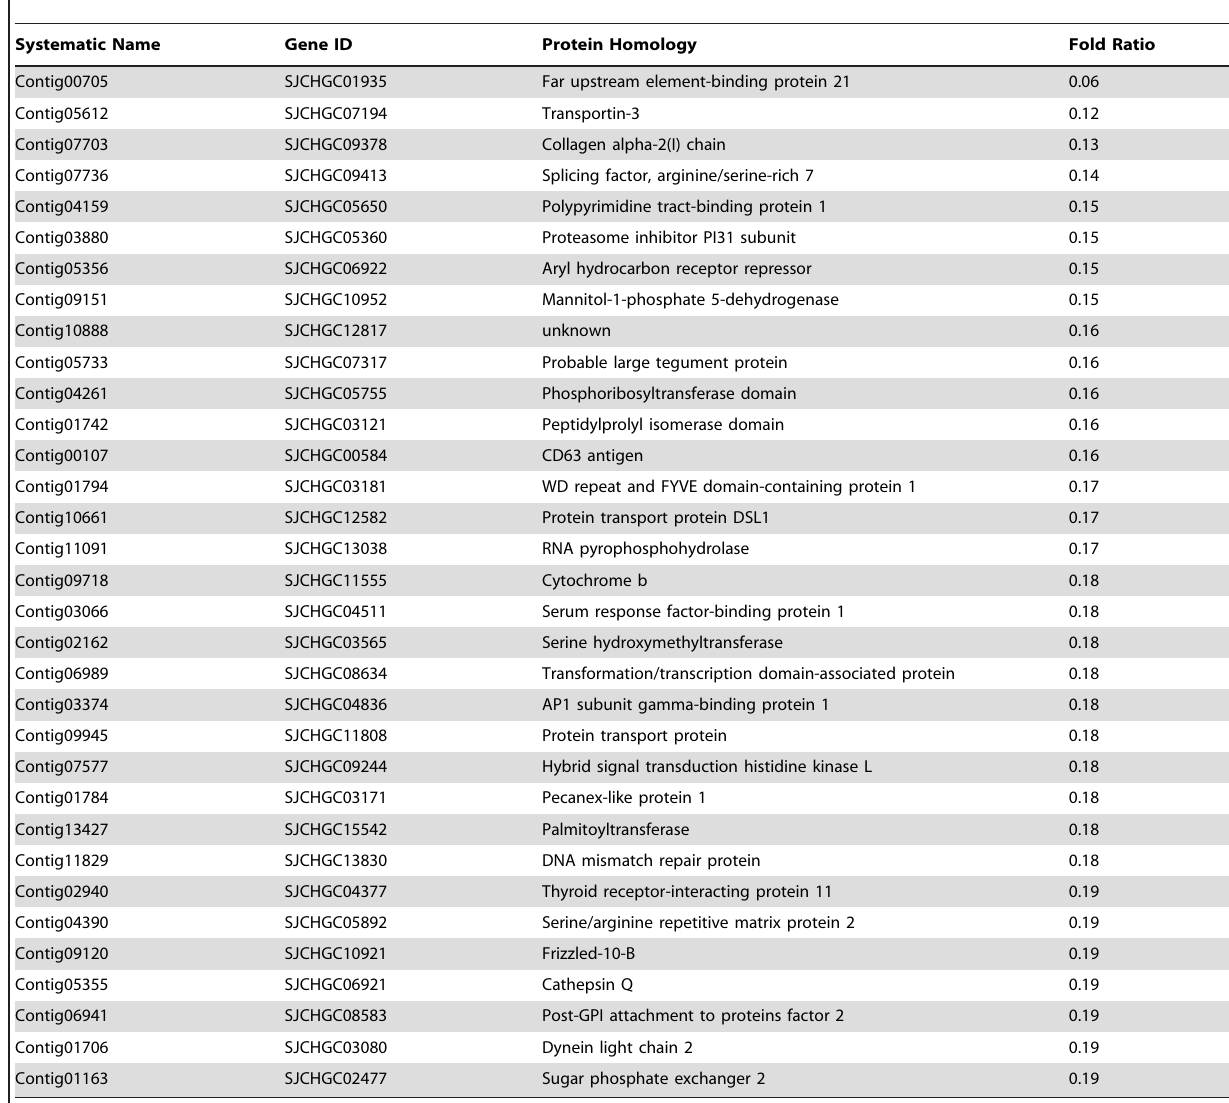
Table 2. Examples of down-regulated expressed genes in schistosomula from Microtus fortis normalized with genes in those in schistosomula from BALB/c